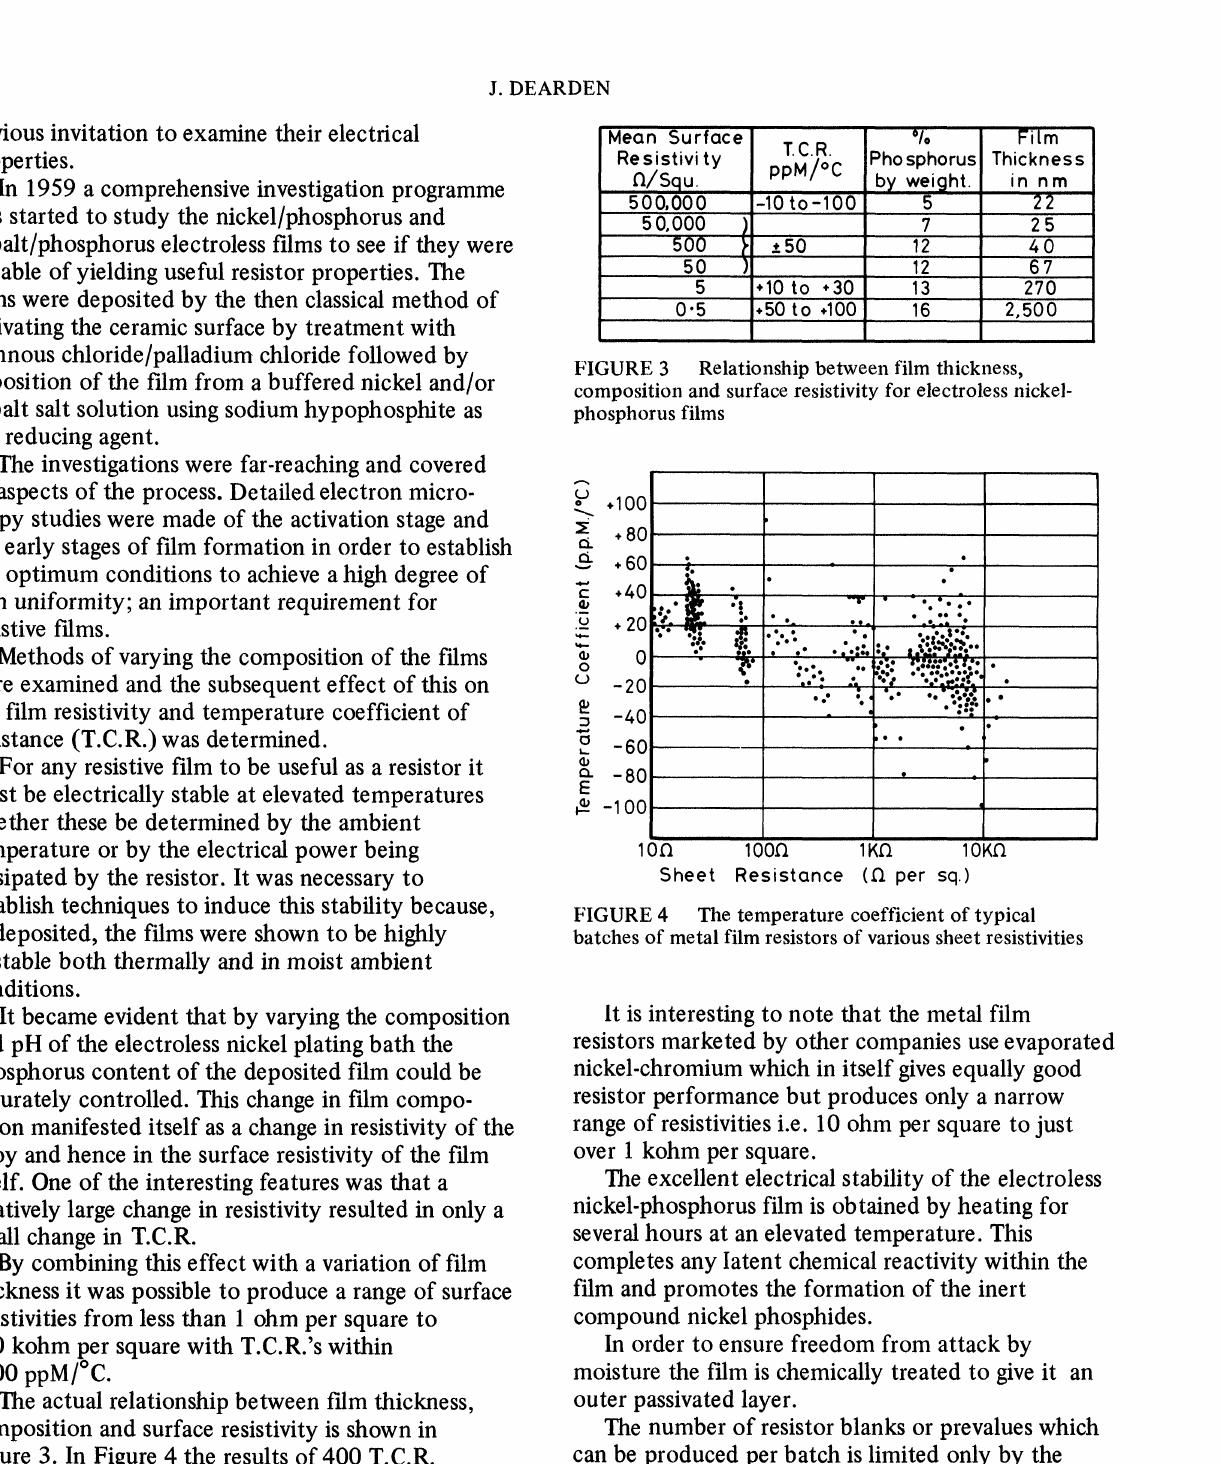
Figure 3. In Figure 4 the results of 400 T.C.R. measurements 2 taken from production control records are plotted against their corresponding surface resistivities. They indicate a mean T.C.R. of +4 ppM/C with a standard deviation of 24 ppM/ C.